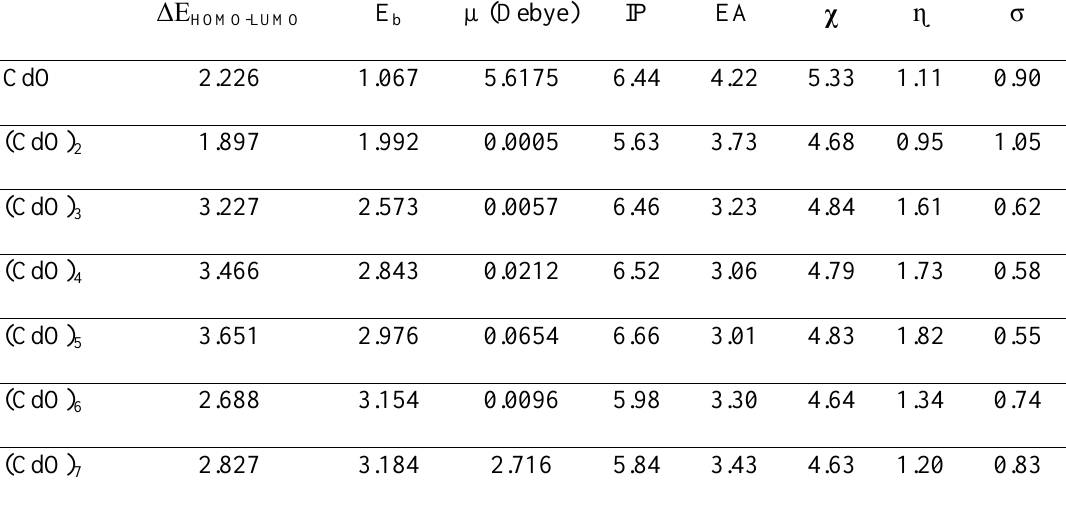
Table 1. HOMO-LUMO energy gap, dipole moment, ionization potential, electron affinity, electronegativity , hardness, and softness of Cu n